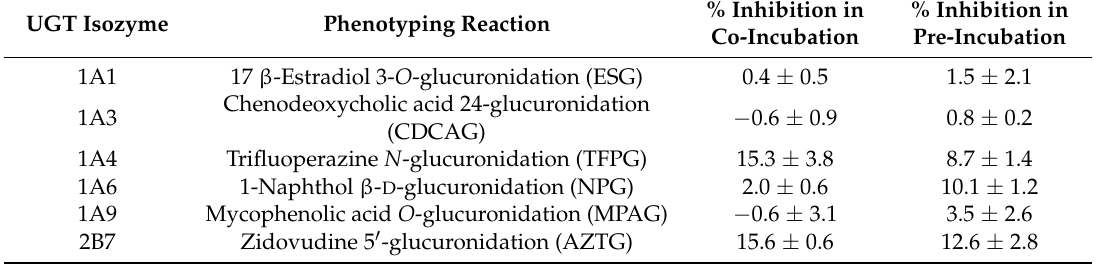
Table 5. UDP-glucuronosyltransferase (UGT) inhibition effects of SKN in human liver microsomes. UGT Isozyme